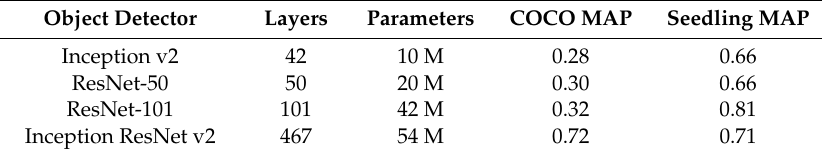
Table 3. Comparison of multiple faster R-CNN backbones. The evaluation metric is MAP@0.5IoU.